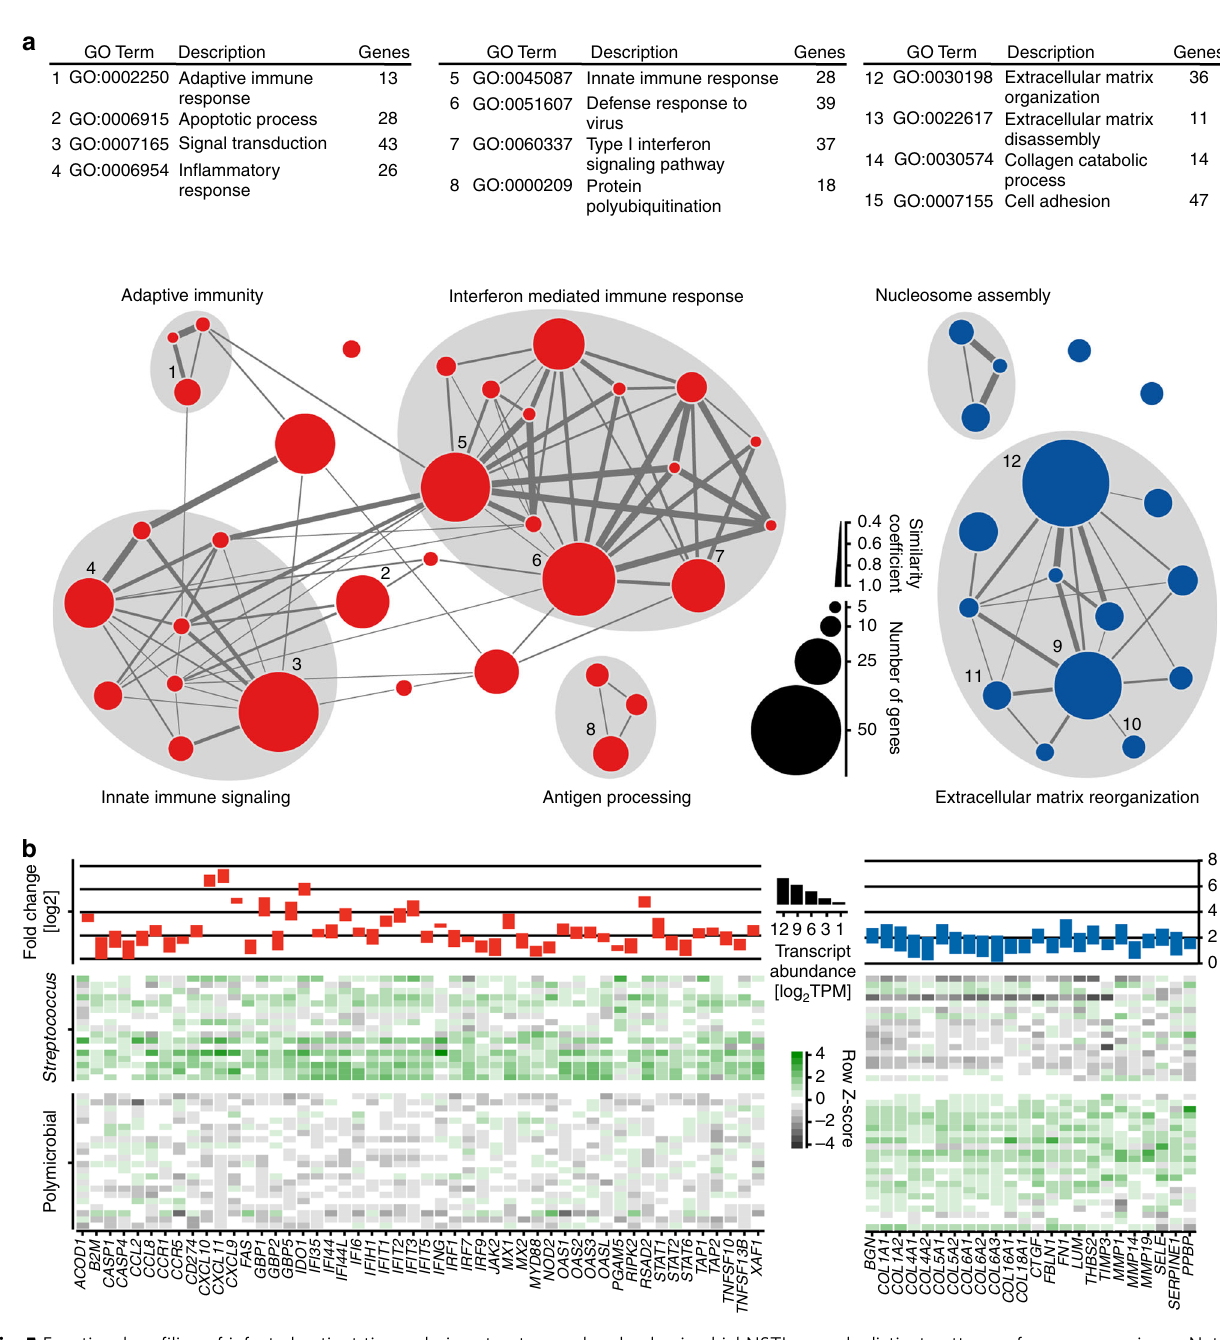
Fig. 5 Functional pro fi ling of infected patient tissue during streptococcal and polymicrobial NSTIs reveals distinct patterns of gene expression. a Network plot of gene ontology (GO) terms enriched within the genes differentially expressed between human tissue biopsies infected with Streptococcus spp. (red, n = 17) or the polymicrobial community (blue, n = 22) (Benjamini – Hochberg adjusted p -value ≤ 0.05, Wald test). Nodes represent enriched GO terms, grouped into functional clusters. b Average expression level, fold change (upper panel) and inter-individual transcriptional variation (lower panel) of selected genes with signi fi cantly higher transcript abundances in human tissue infected by Streptococcus spp. (red) or by a polymicrobial community (blue). Source data are provided in Supplementary Data 5, 7, and